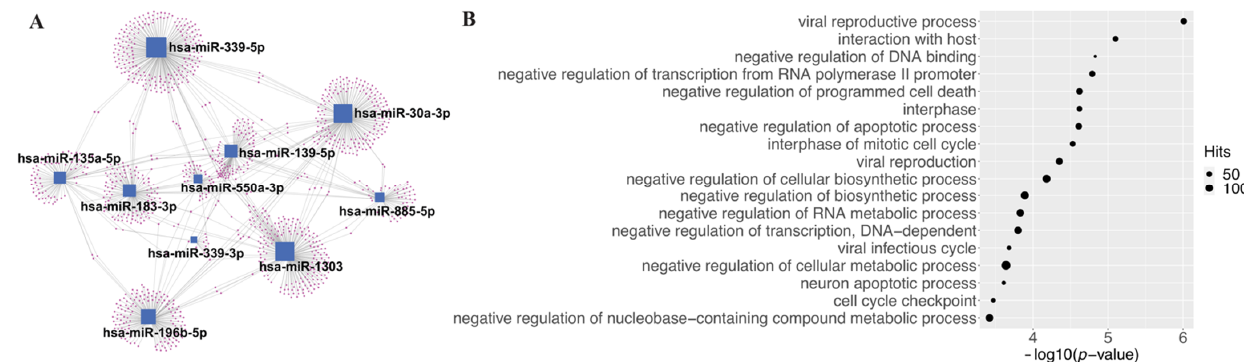
Figure 3. Results of pathway and network analyses for the 10 candidate miRNAs. ( A ) MiRNA-gene network for ten potentially causal miRNAs of severe COVID-19. Blue squares indicate miRNAs, and red dots indicate corresponding target genes. Edges between each blue square and red dot represent that the gene can be targeted by the miRNA. ( B ) Function enrichment analysis of target genes on the biological process (BP) GO pathways (only the top 18 enriched pathways are shown).